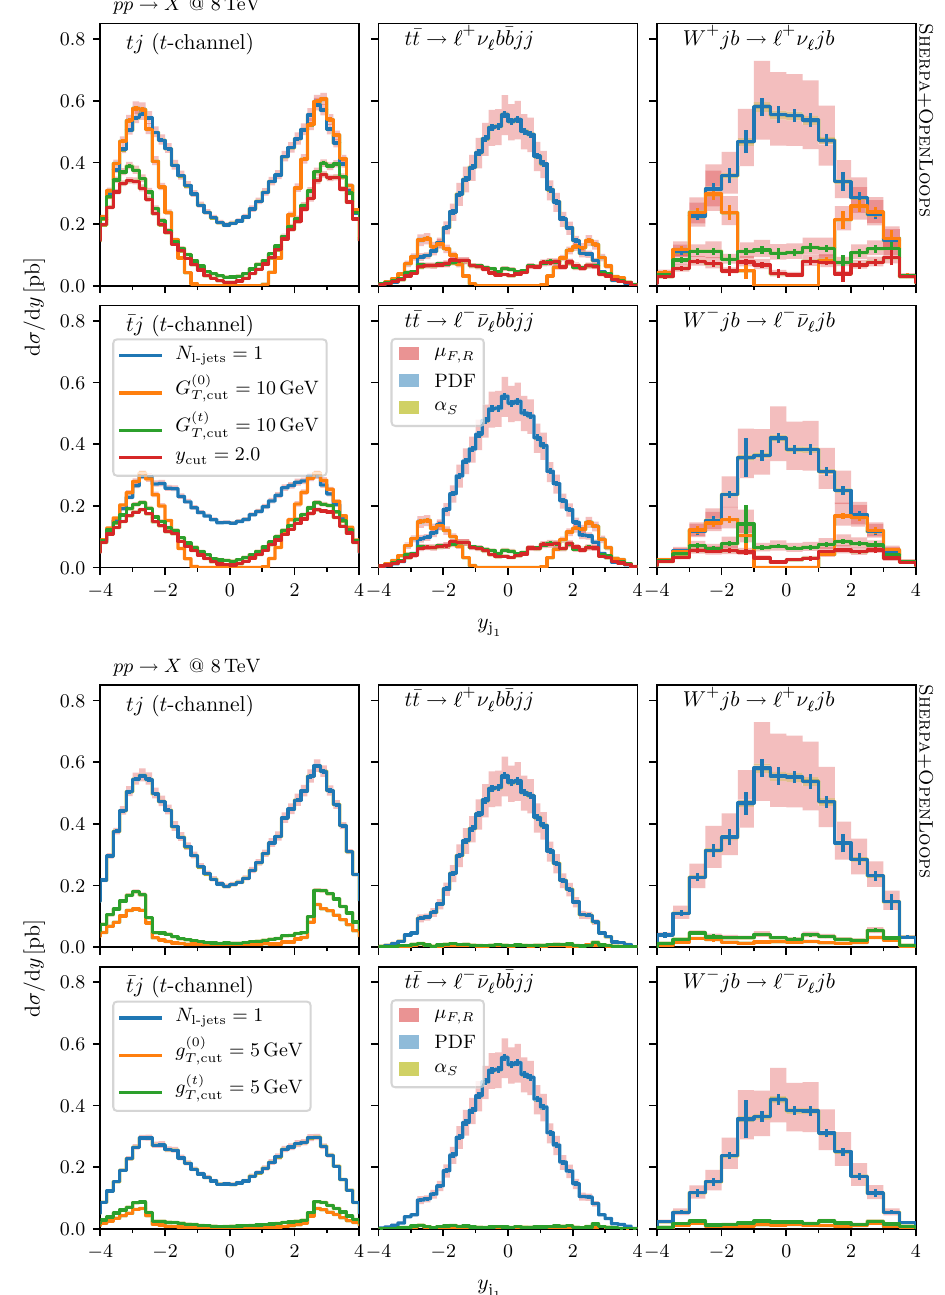
Fig. 7 S HERPA M C @N LO results for the leading-jet rapidity y j defined in Sect. 3, with various alternate cuts replacing the N l-jets = 1